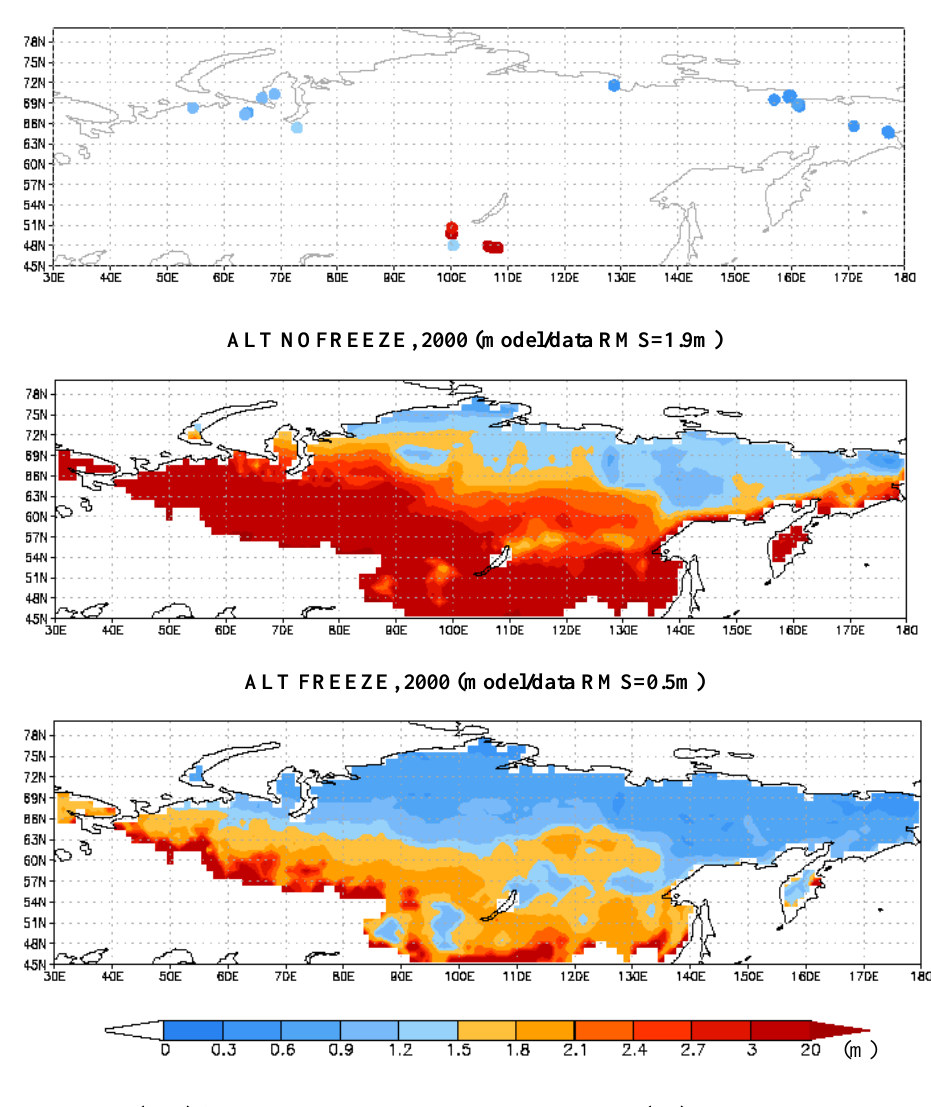
Fig. 10. Active layer thickness (ALT) for the year 2000 as observed at CALM stations (top); as modeled without the soil freezing scheme (center); and as modeled with the soil freezing scheme